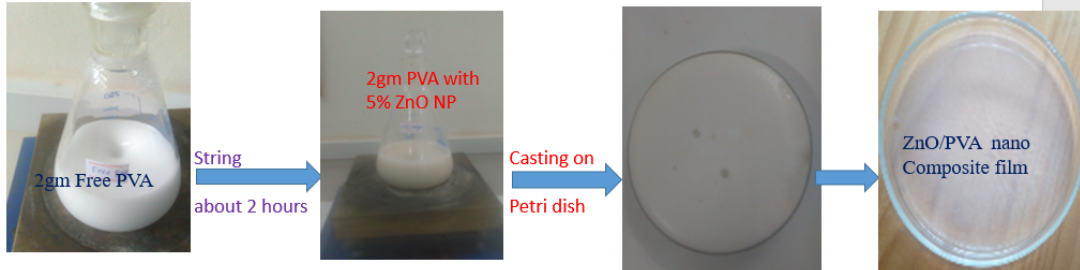
Figure 3: Schematic of synthesis of ZnO/PVA